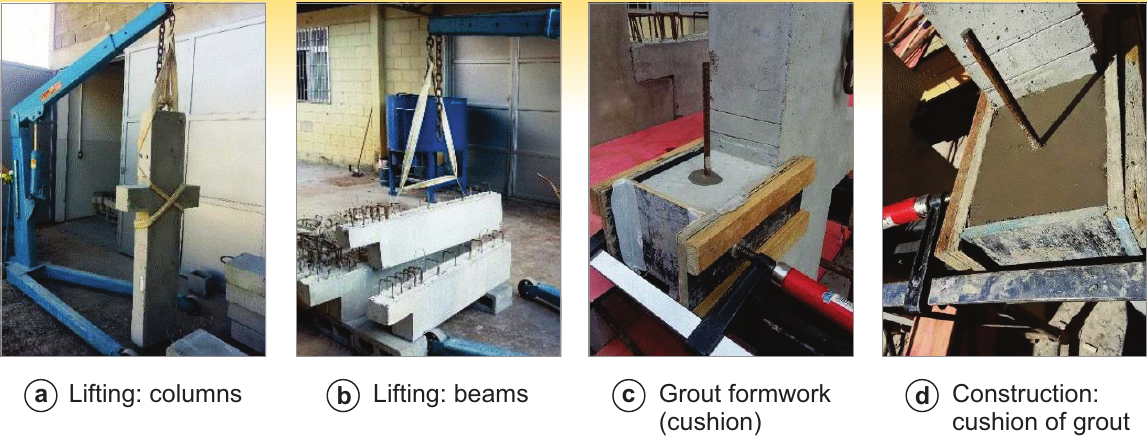
Figure 12 Lifting of the precast elements, steel dowel and cushion of grout of the beams